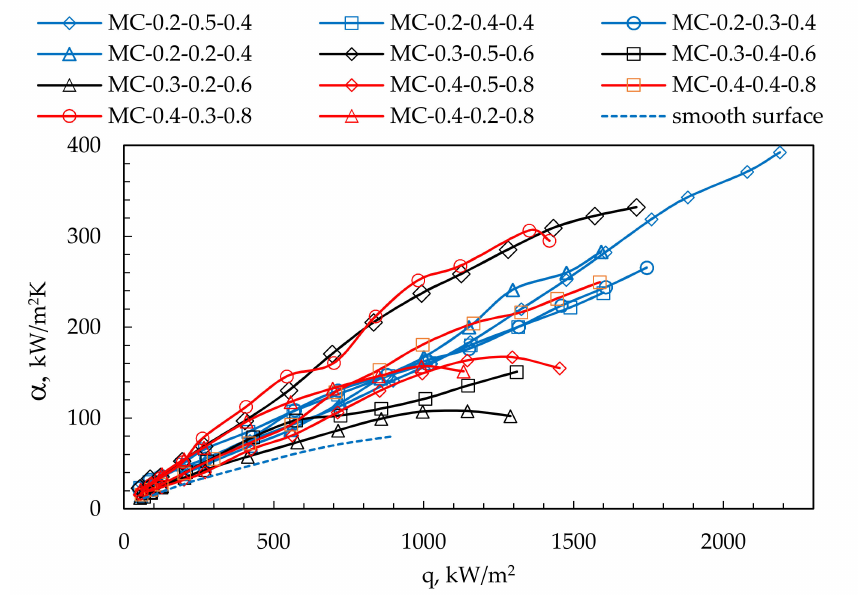
Figure 6. Boiling curves for water: heat transfer coefficient vs. heat